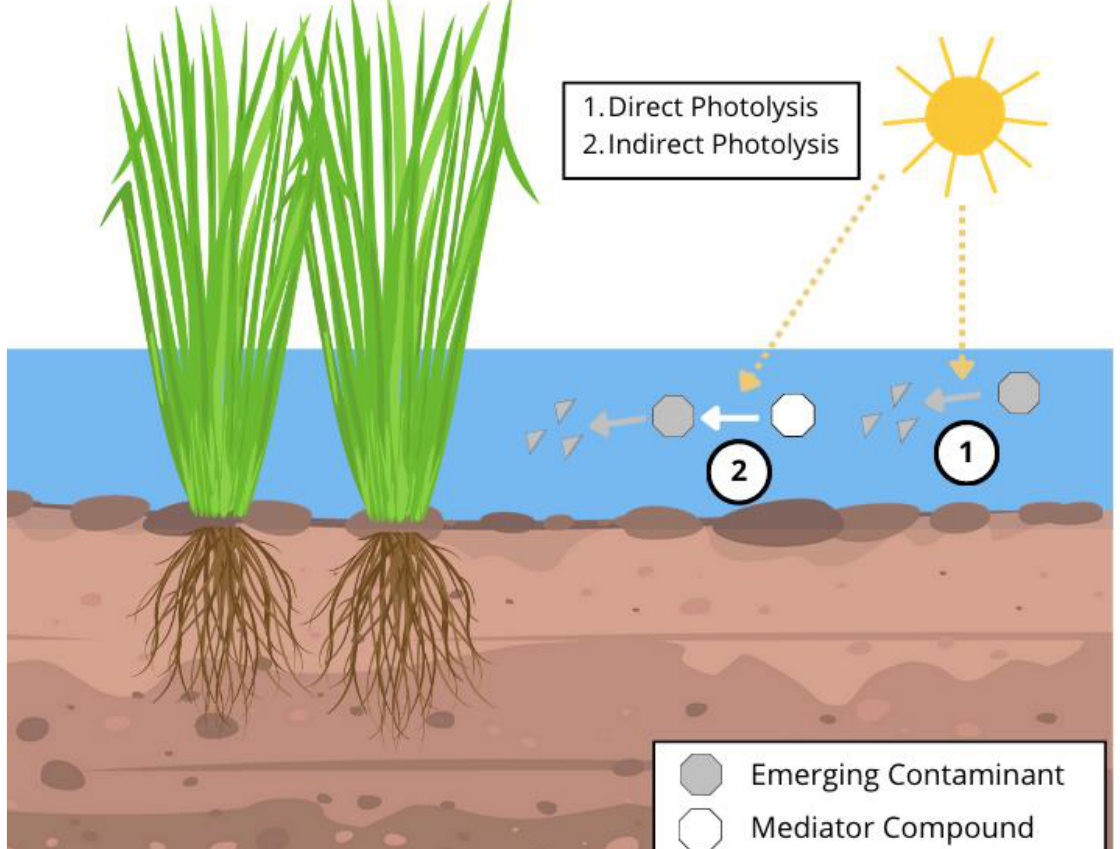
Figure 3. Photodegradation of emerging contaminants in wetlands. Photodegradation occurs through direct photolysis of the compound, or is mediated by another compound, shown in white, through indirect photolysis. Octagons represent parent compounds; triangles represent transformation products.